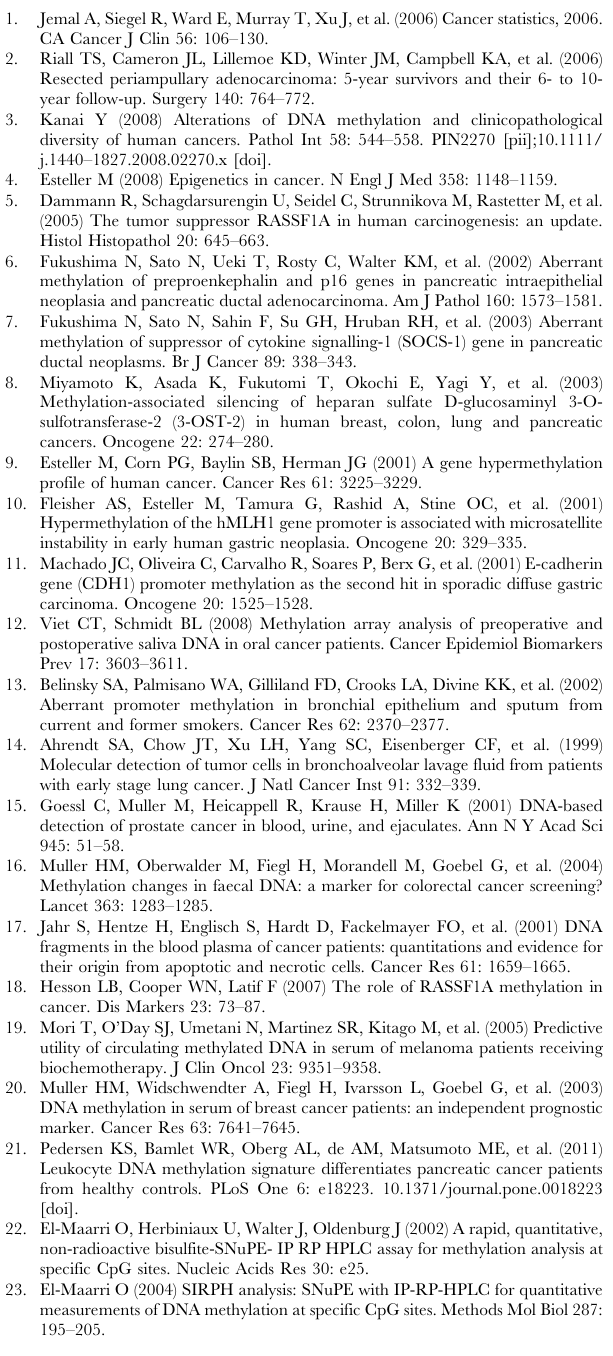
patient peripheral blood; tissue: patient tumor tissue) and control group